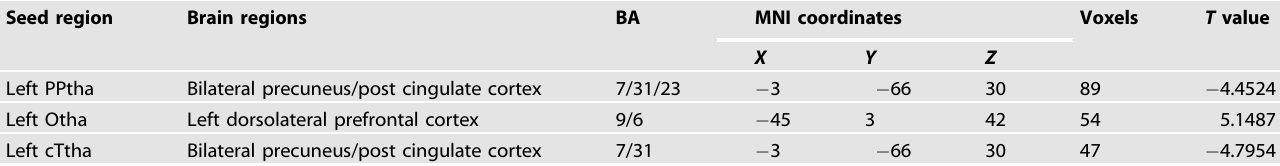
Table 2. Functional connectivity showing signi fi cant differences in MDDs and HCs before BMRM. Seed region